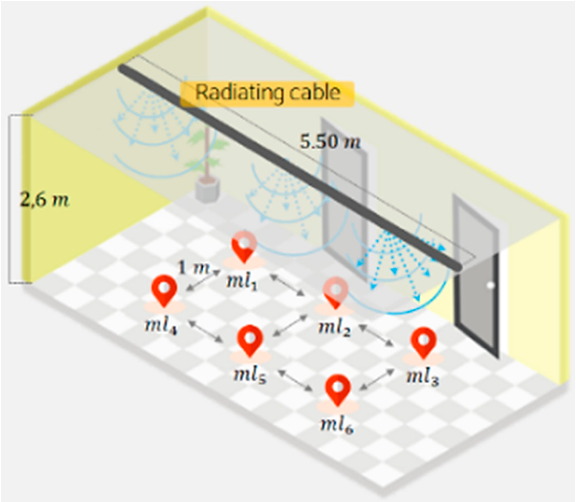
Figure 4. Measurement locations map.